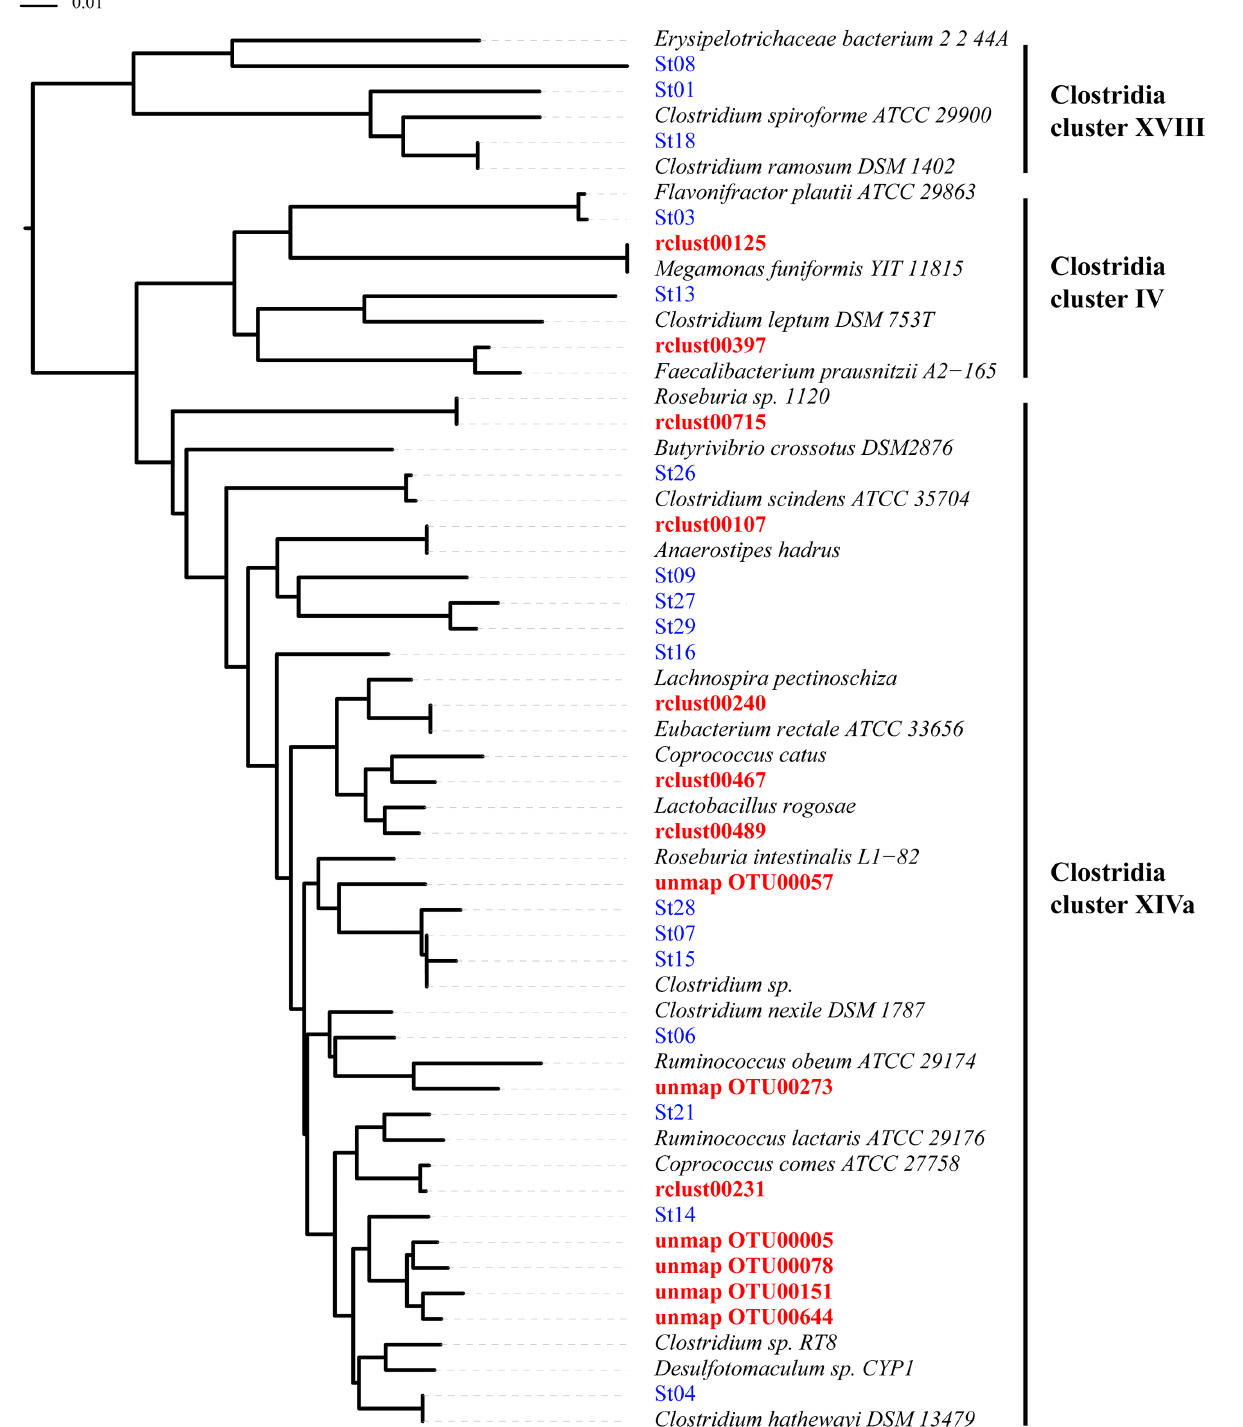
Fig 5. Phylogenetic tree of 14 clostridial species exhibiting significant differences among groups and several known species. The neighbor-joining method was used to construct the phylogenetic tree. Numbers at each node indicate the bootstrap support (1,000 replicates). Those written in red letters are 14 clostridial species having a significant difference in relative abundance between HC40 and MS20 samples. Treg-inducing strains are indicated by “ St ” and are written in blue letters [13].